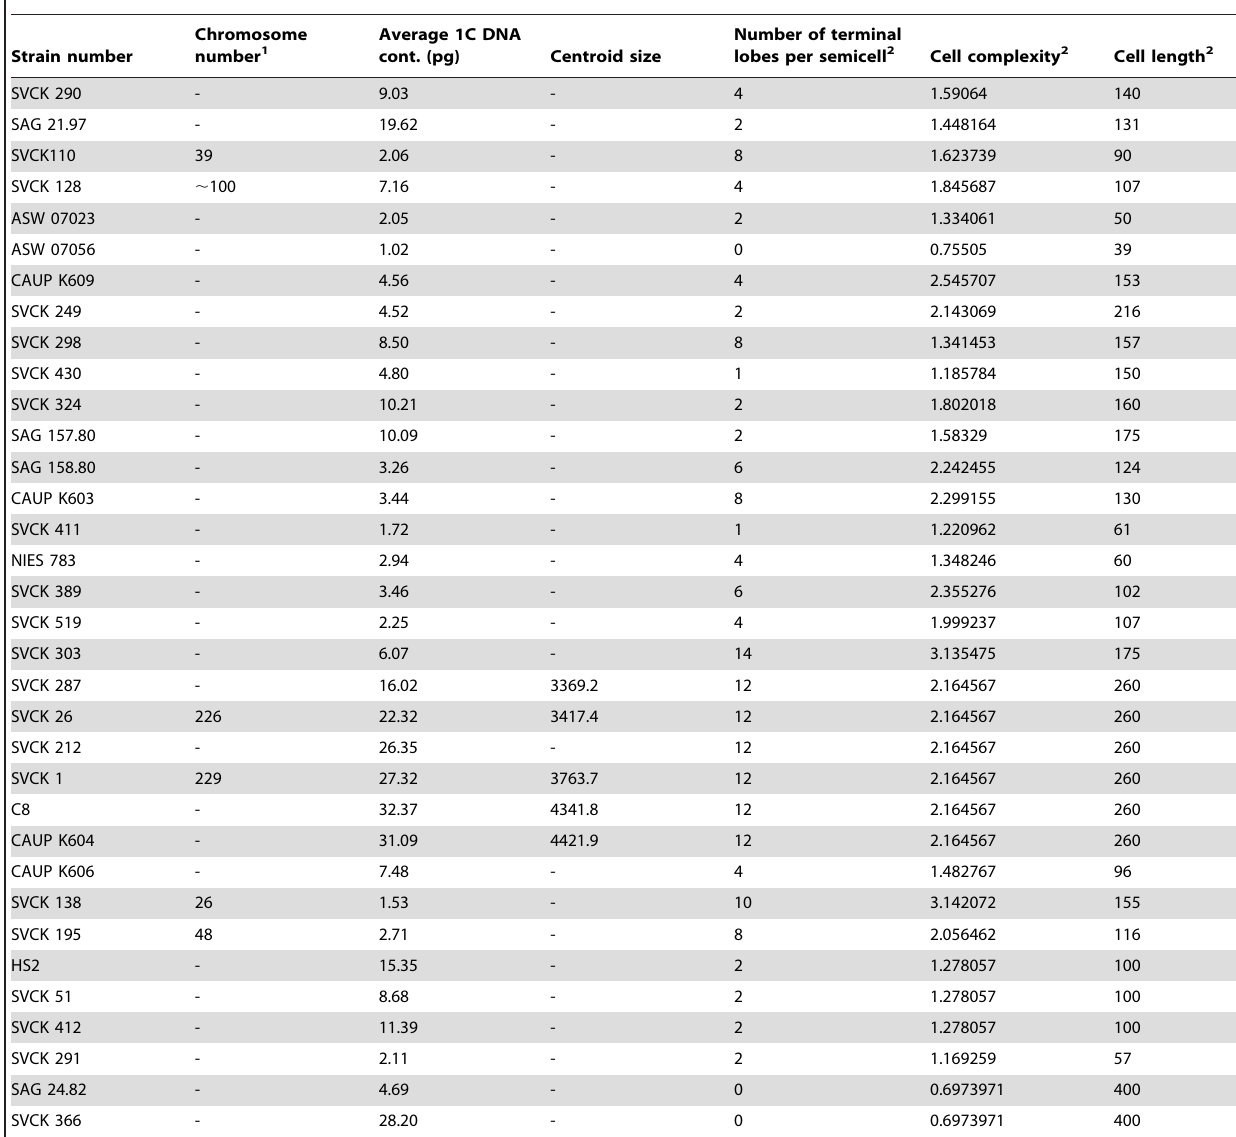
Table 3. Cytogenetic and morphometric characteristics of the analyzed strains. Species names are given in Table